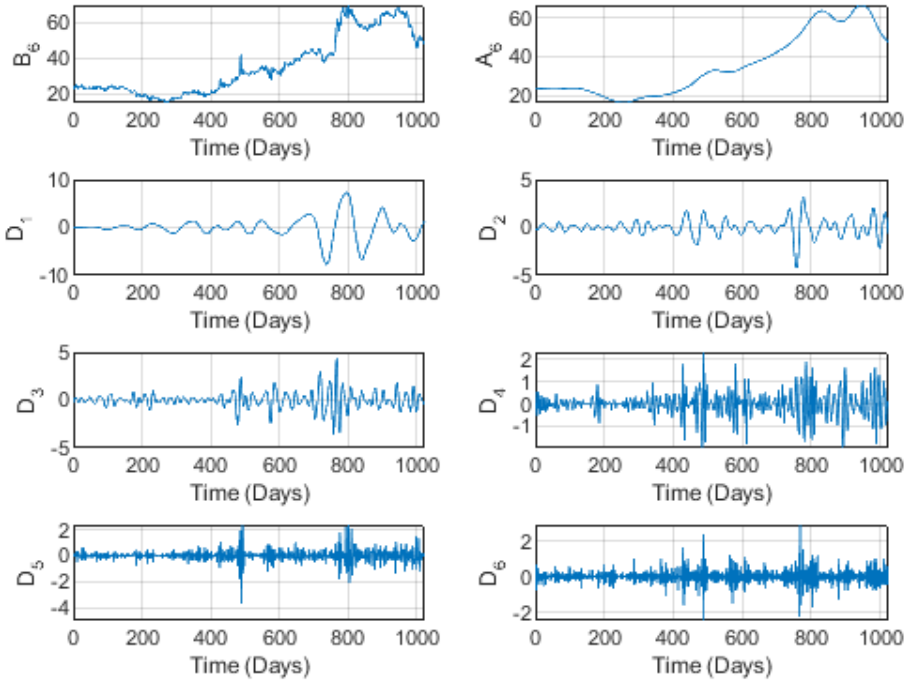
Figure 11. The wavelet decomposition of the Al Aseel brand B 6 prices at level